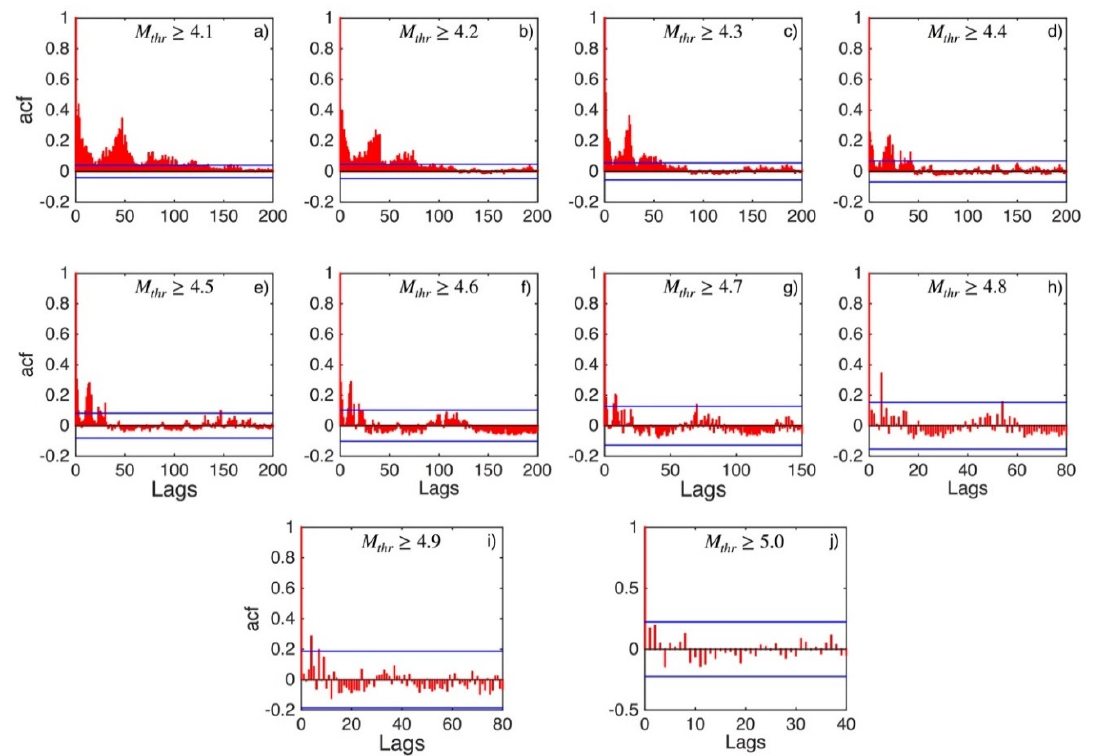
Figure A10. ACF values (red stems) and their 95% confidence intervals (blue lines) for Southeast Aegean Sea (sub-area 5) for magnitude thresholds ( M thr ) varying from 4.1 to 5.0 (subplots a – j ).